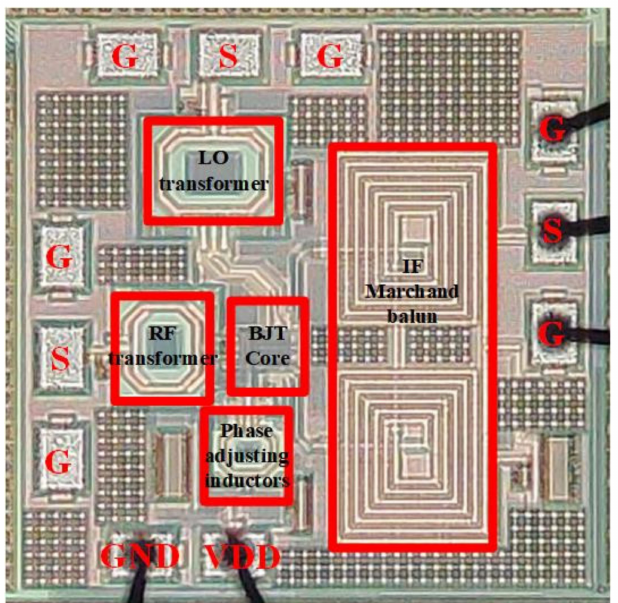
Figure 14. Chip photograph of the proposed mixer with a chip size of 0.69 × 0.69 mm 2 including